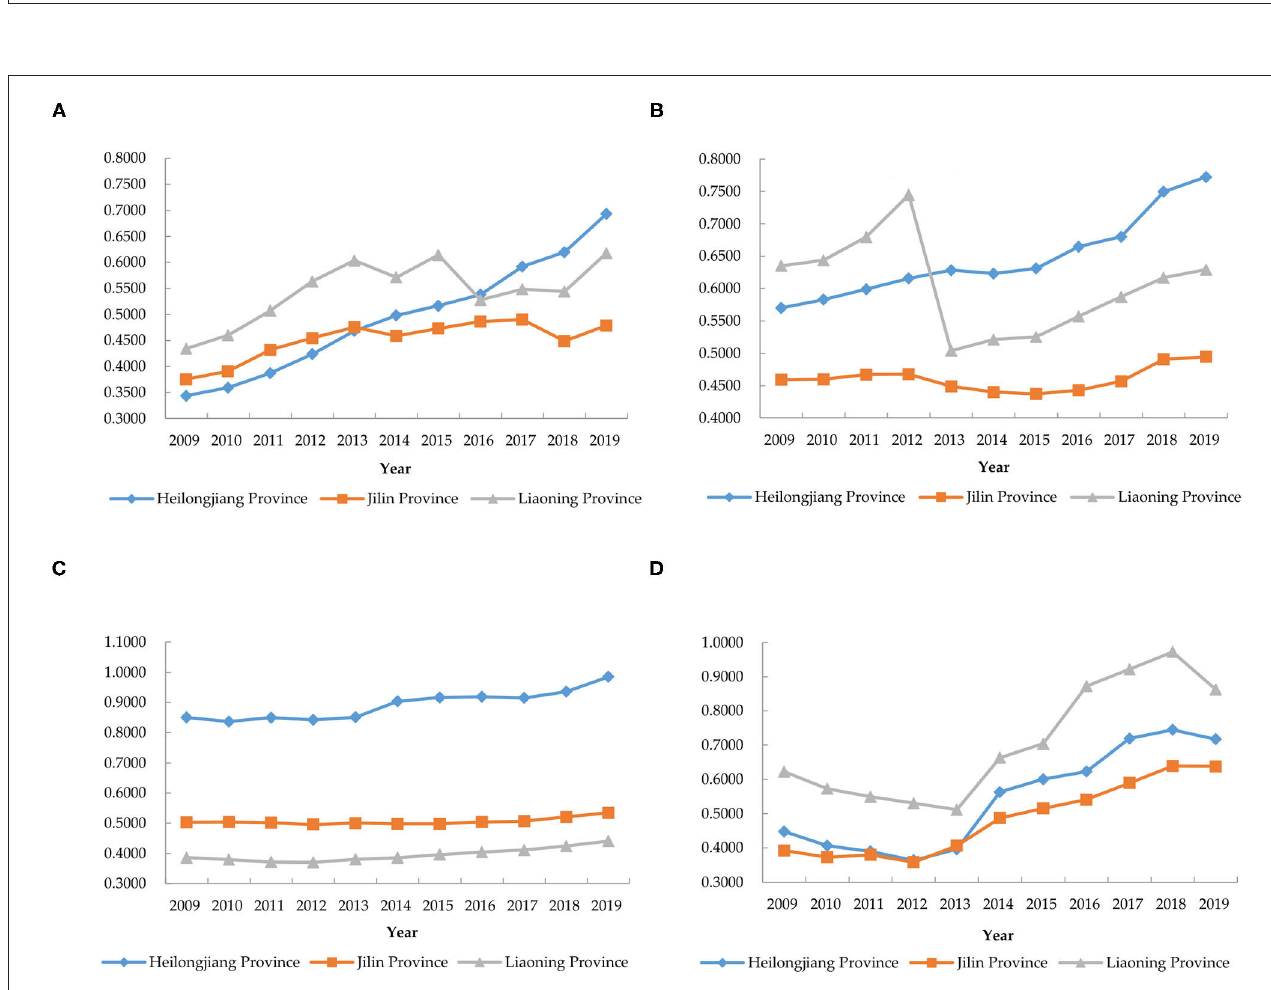
Frontiers in Public Health |